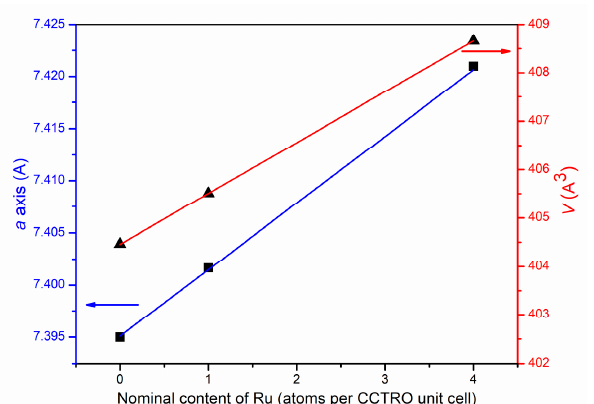
Figure 2. Relationship between the unit cell parameters and cell volume with a nominal content of Ru atoms per CCTRO unit cell.